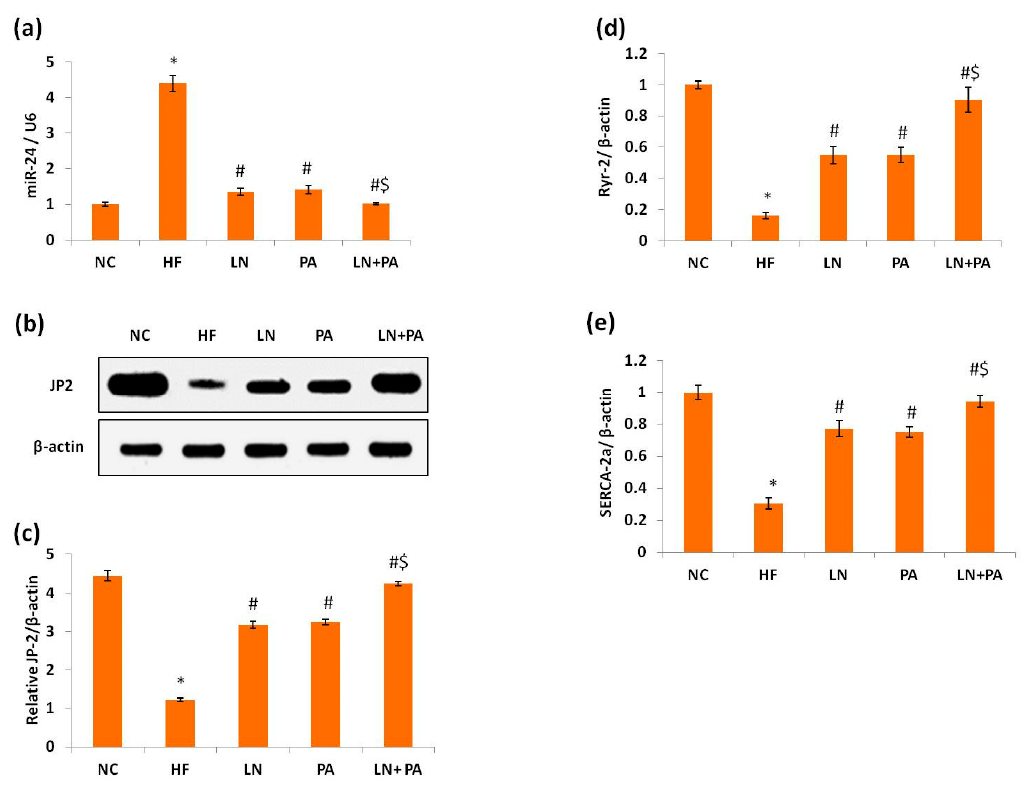
Figure 5. miR24 and LCC-RyR signaling in the left ventricle of rats with heart failure.HF was induced with doxorubicin (3.5 mg/kg, i.p., twice weekly for 3 weeks) and rats were treated with PA (10 mg/kg), LN (10 mg/kg) and their combination (PA + LN) orally and daily for 4 weeks. Left ventricular expression of miR-24 ( a ), JP-2 ( b ) representative Western blotting of JP-2 and β -actin, ( c ) quantitation of JP-2 protein expression normalized to β -actin housekeeping protein and mRNA expression of ( d ) RyR-2 and ( e ) SERCA2a. Data are mean ± SD, n = 6. * p < 0.001 compared to the NC group, # p < 0.001 compared to the HF group, $ p < 0.001 compared to both LN and PA groups. Abbreviations: junctophilin-2, JP-2; ryanodine receptor 2, RyR2; sarcoplasmic/endoplasmic reticulum Ca 2+ -ATPase 2, SERCA2. Table 1. Correlation between studied parameters in HF rats treated with LN, PA and their